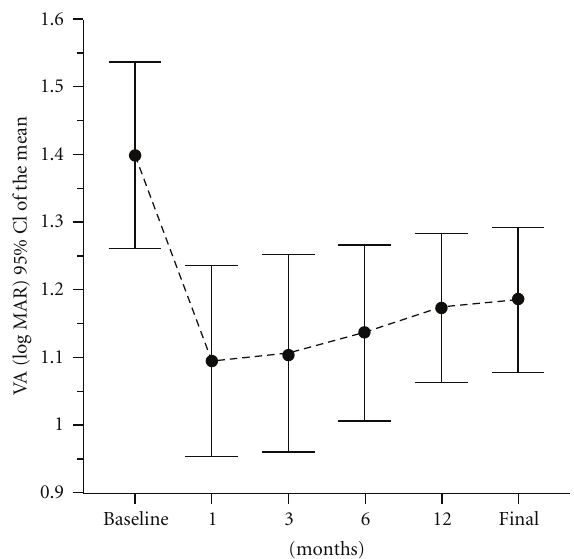
Figure 1: Evolution of change in logMar visual acuity over 14 months after intravitreal injection of bevacizumab showing statis- tically significant improvement.